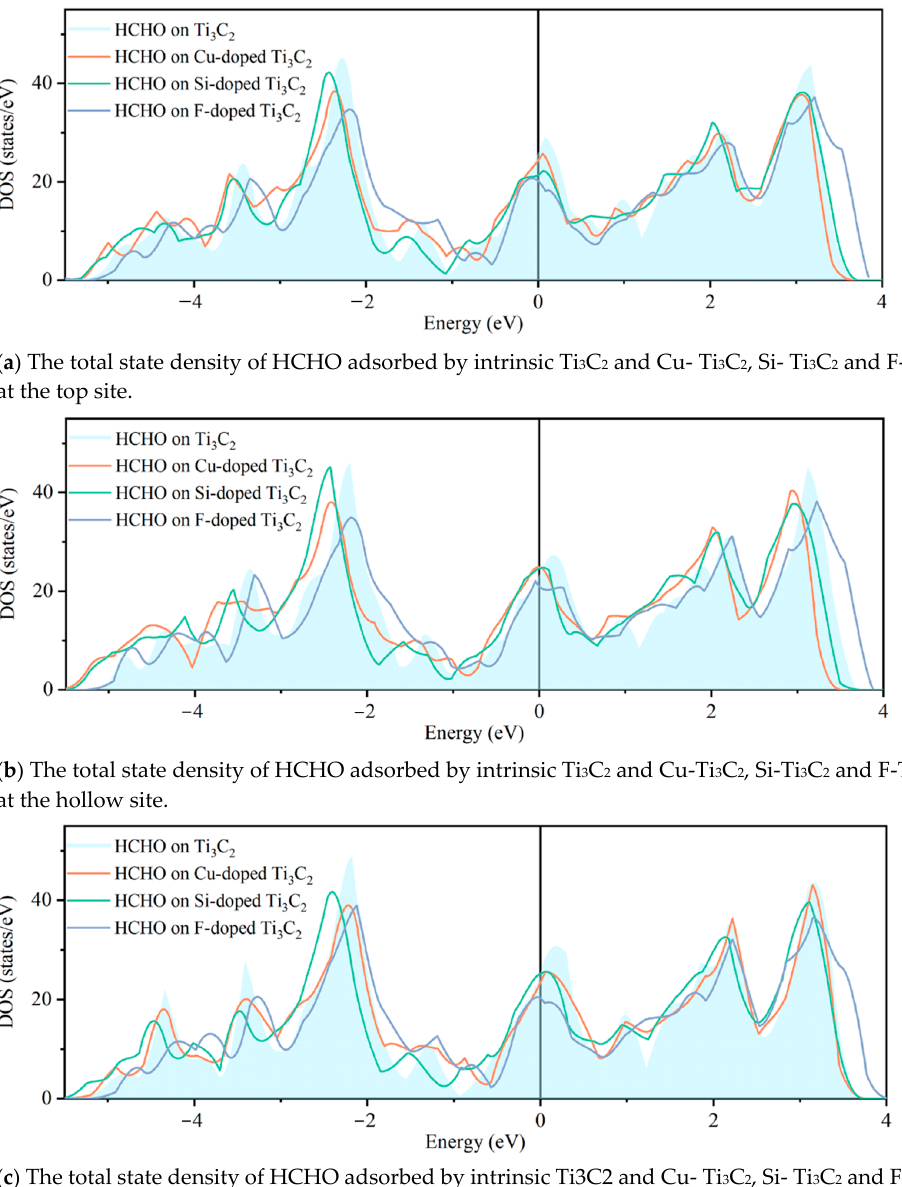
Figure 6. The state density of each adsorption system.